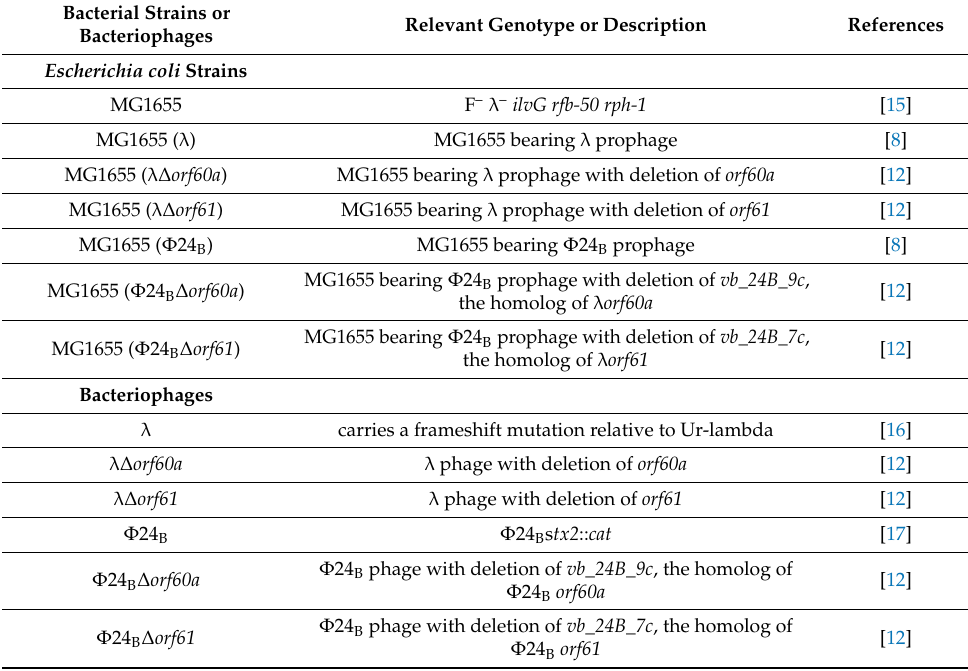
Table 1. Bacterial strains and